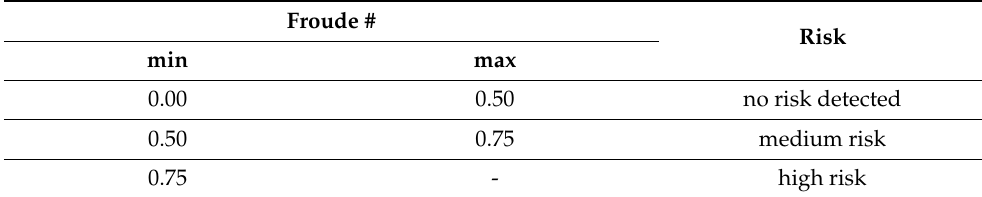
Table 3. Classes of Froude # taken for the analysis of flow